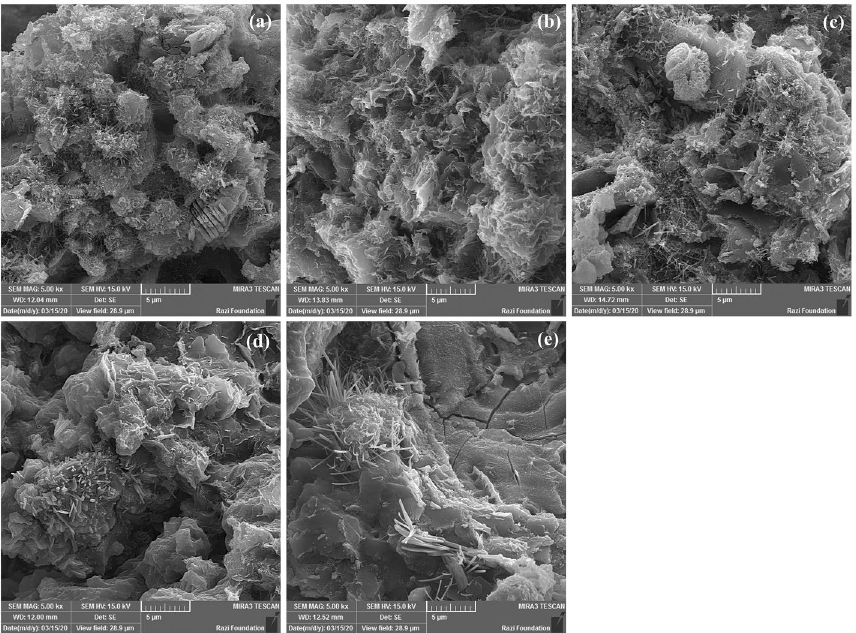
Fig. 21 The SEM images of mixtures with cement of 15% and different fine additives under 150 magnification: a S-C15 mixture, b S-C15-B10 mixture, c S-C15-K10 mixture, d S-C15-B30 mixture, e ) × S-C15-K30